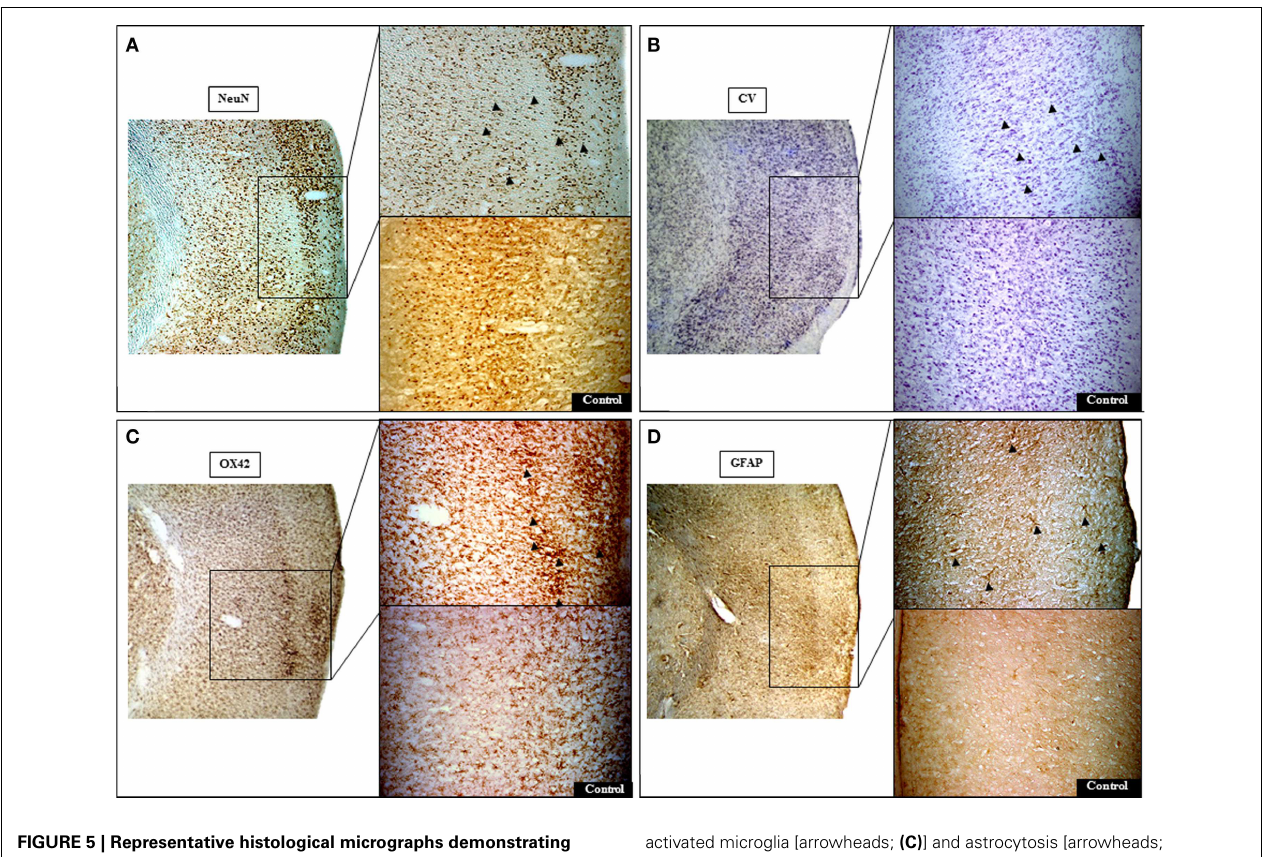
FIGURE 5 | Representative histological micrographs demonstrating pure selective neuronal loss (SNL) in 15min MCAo rat # 1 (bregma + 1mm) . Areas of SNL are clearly documented on NeuN (A) and less clearly so on Cresyl violet (CV) staining (B) . At higher resolution, NeuN staining revealed neuronal alterations ranging from clumping and condensation of nuclear chromatin (fragmented appearance) to pyknotic nuclei (arrowheads) that are less conspicuous on CV. Note prominent